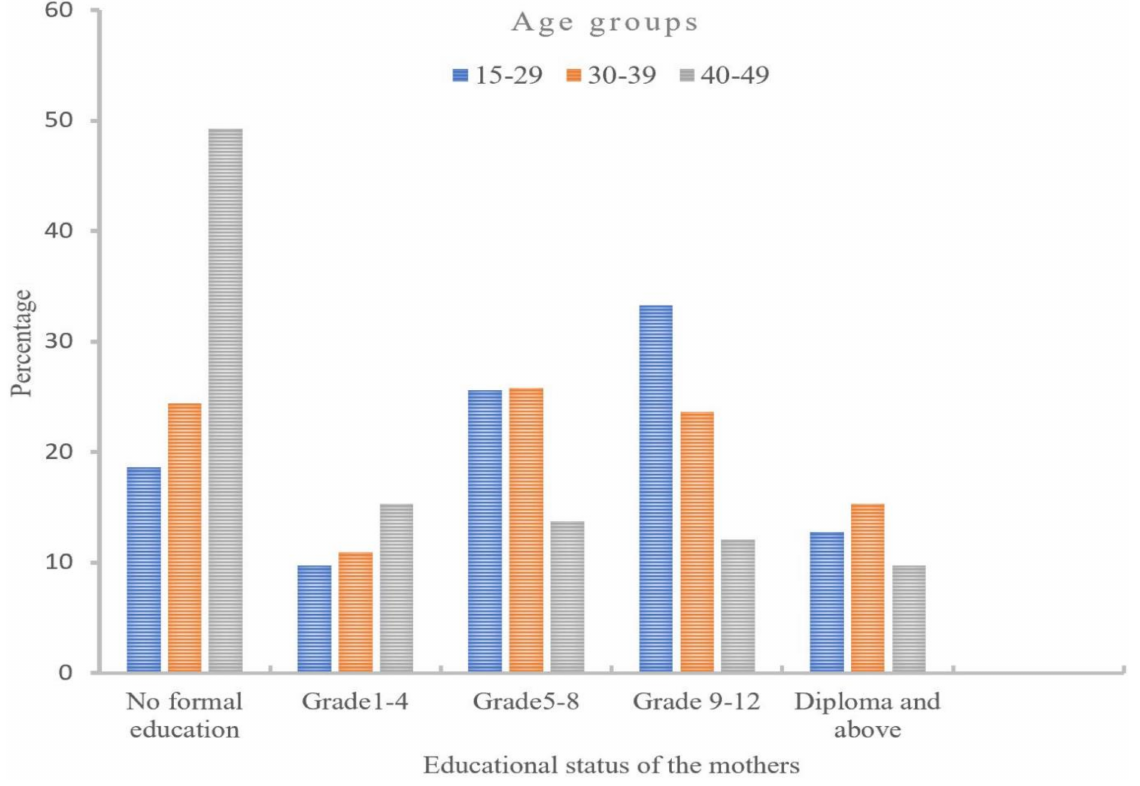
Figure 1. Respondents educational status by age